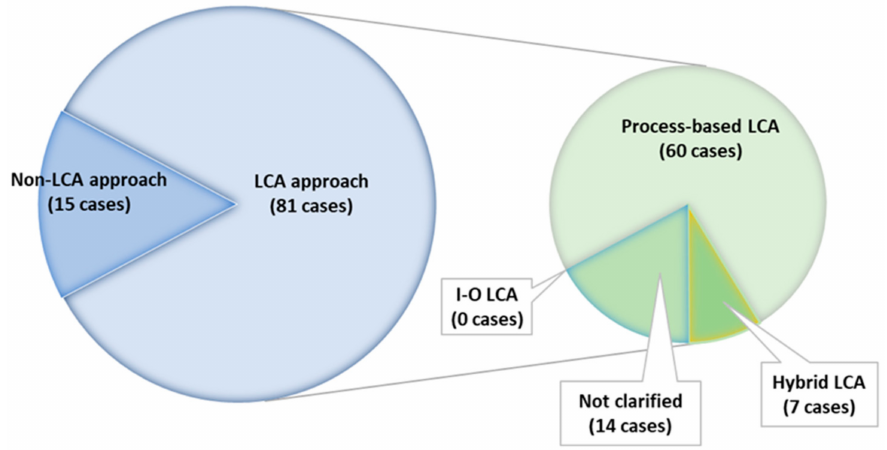
Figure 9. Number of reviewed building cases adopting different carbon quantification